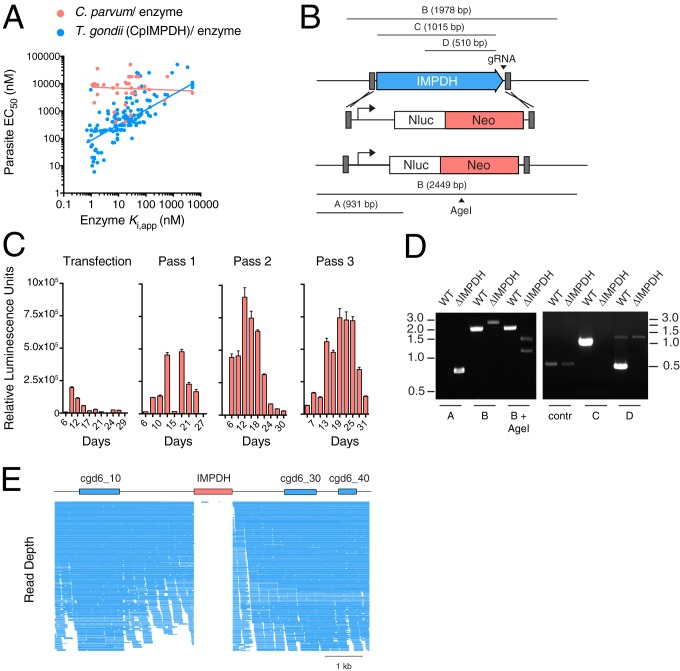
Targeting of the C. parvum inosine monophosphate dehydrogenase locus. (A) Comparison of the impact on parasite growth and enzyme inhibition of multiple series of IMPDH inhibitors (each symbol represents one compound; see Results for reference). Note that for T. gondii engineered to depend on C. parvum IMPDH [HXGPRT deletion and IMPDH replacement (12)], potency of compounds against the organism correlates with that of the recombinant enzyme over 4 orders of magnitude (r2 = 0.17, P < 0.0001); no correlation is observed for C. parvum. (B) Modified targeting procedure using 50-bp flanking sequences (gray). PCR products used to map the WT and insertion locus are labeled “A” to “D.” To further validate ablation, amplicon B produces a pattern distinguishing WT and ΔIMPDH when treated with the restriction enzyme AgeI. (C) NanoLuciferase activity was measured in the feces of mice infected with transfected parasites. The emerging paromomycin-resistant parasites were passed multiple times in animals, demonstrating the viability of the strain. Samples were pooled from 4 to 6 mice in triplicate; error bars are SD. (D) PCR mapping of WT and ablated locus (ΔIMPDH) -producing amplicons illustrated in B. (E) WT and ΔIMPDH C. parvum were subjected to whole-genome sequencing. Individual sequence reads mapping to IMPDH and surrounding loci in ΔIMPDH are shown. Note gene loss.